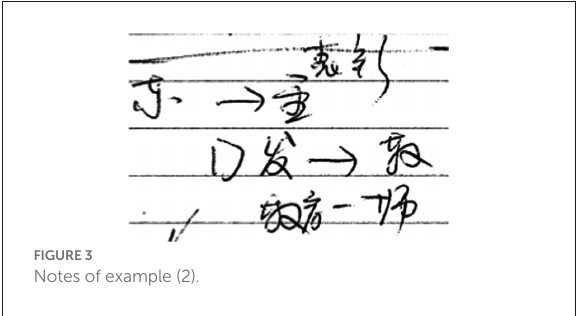
FIGURE 3 Notes of example